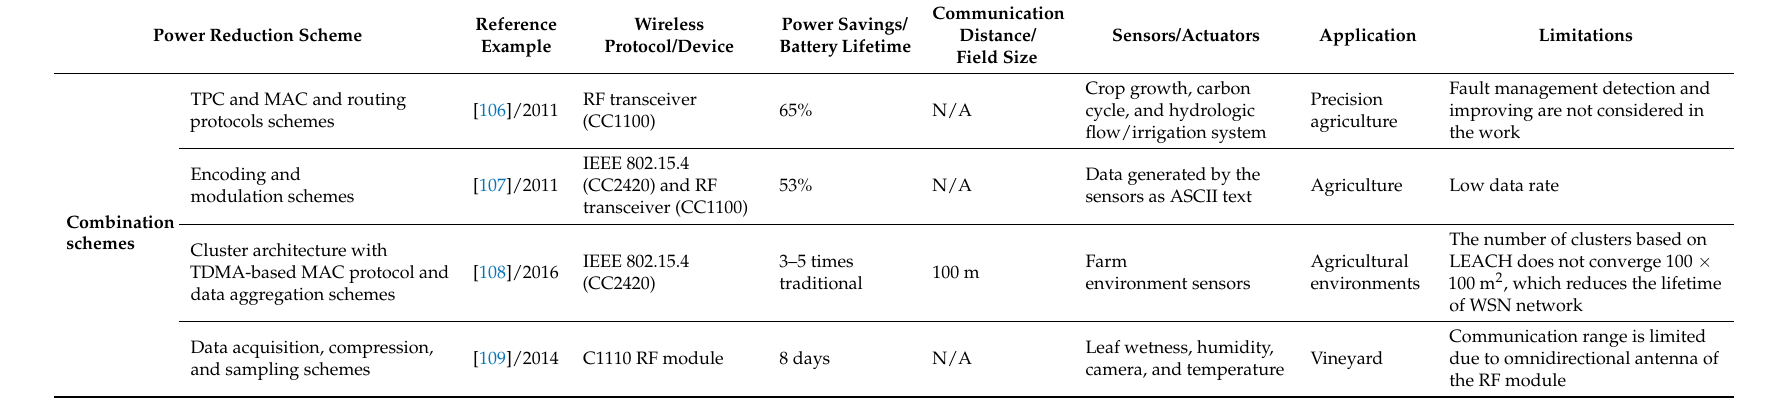
Table 6. The combination of power reduction schemes for previous research in agricultural